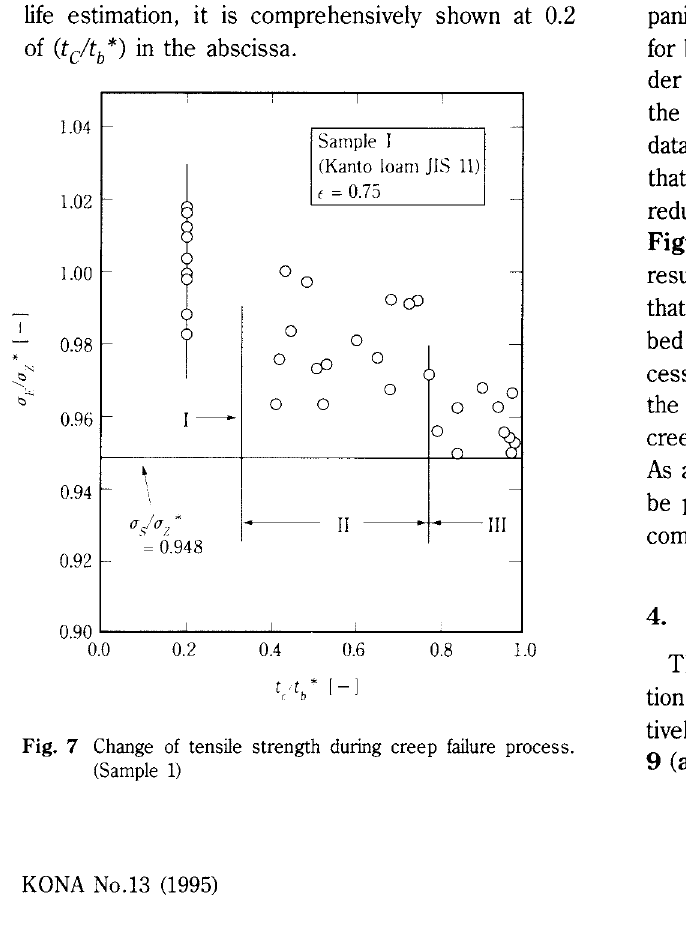
KONA No.13 (1995)